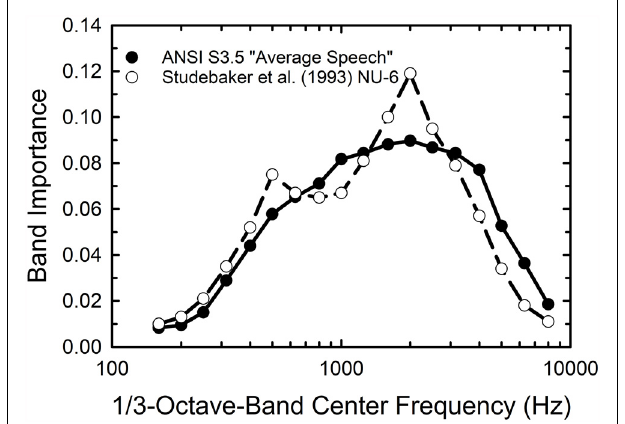
FIGURE 1 | One-third octave-band importance weights for average speech (filled circles) and the Northwestern University Auditory Test No. 6 (NU-6) monosyllables from the American National Standards Institute (1997) standard for the Speech Intelligibility Index